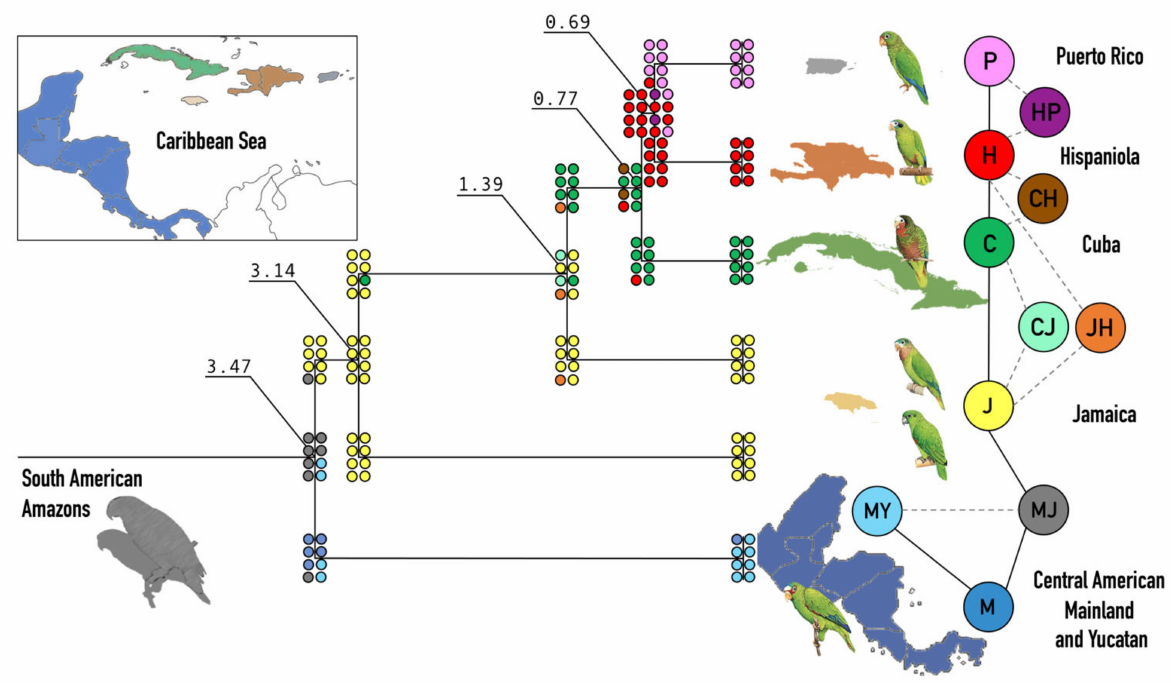
Figure 5. Visual summary combining speciation patterns predicted by eight different biogeographical models tested to infer possible speciation and dispersal routes. The eight models (DIVALIKE + X, DIVALIKE + J, DIVALIKE2 + X, DIVALIKE2 + J, DEC + x, DEC + J, BAYAREALIKE + X, BAYAREALIKE + J) from the BioGeoBEARS package [54] using a distance matrix based on the shortest distances between the islands scenario and evolutionary history of the Amazon parrot species in the Greater Antilles based on the data from this study (Supplementary Figure 2 and Supplementary Figure S2). All eight models are fully described in Supplementary Figure S7 and represented by eight circles at each node (following the order in Supplementary Figure S7A–H) and summarized in Table 1. The colors of the circles represent the area where the speciation was predicted to occur by a specific model (M—Central American mainland; MY—Central American Mainland and Yucatan; MJ—Central American Mainland and Jamaica; J—Jamaica, CJ—Cuba and Jamaica; JH—Jamaica and Hispaniola; C—Cuba; CH—Cuba and Hispaniola; H—Hispaniola; HP—Hispaniola and Puerto Rico; P—Puerto Rico). Numbers on the arrows show approximate ages of the internal nodes in millions of years listed in Supplementary Table